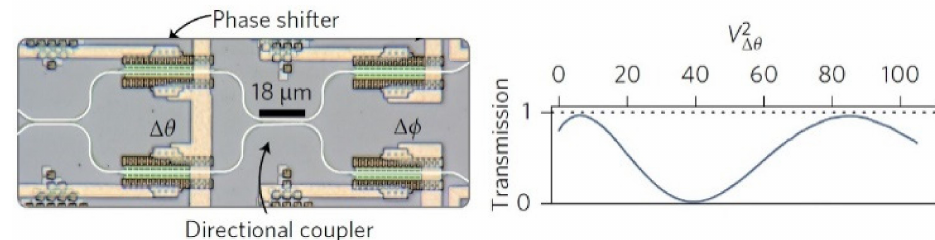
Figure 6. The programmable phase shifter creates modifications in the phase, which, in turn, are converted to amplitude modifications in the directional coupler [64].